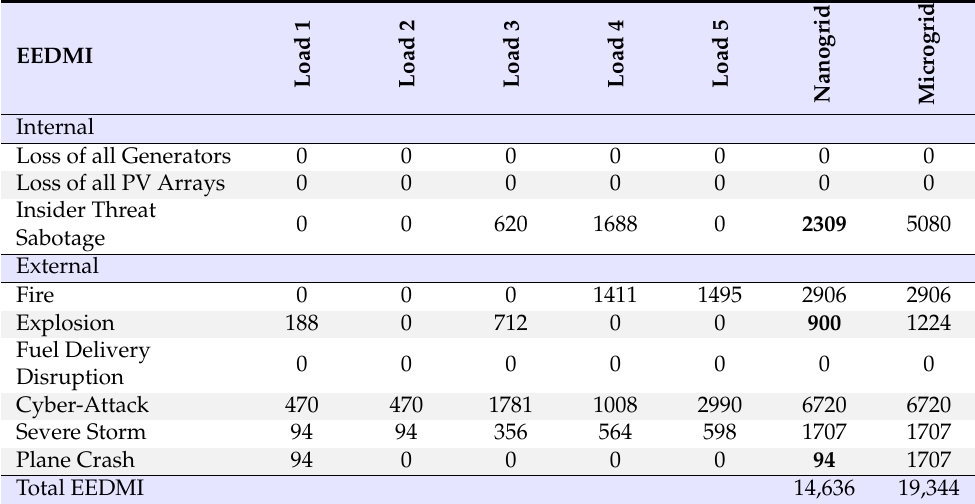
Table 9. EEDMI Simulation Results. These values are resilience measurements for each threat scenario and are compared between the existing microgrid and the potential nanogrid configuration. Bold values indicate lower (preferred)